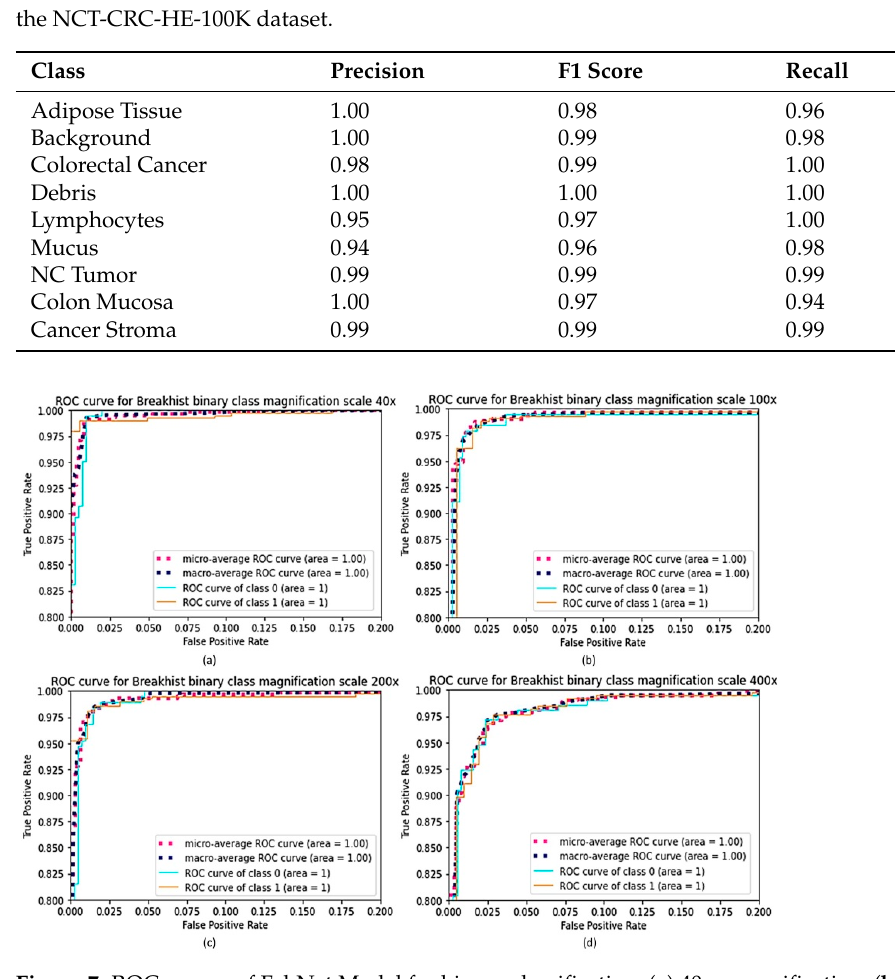
Figure 7. ROC curves of FabNet Model for binary classification, ( a ) 40× magnification, ( b ) BreakHis 100× magnification, ( c ) BreakHis 200× magnification, ( d ) BreakHis 400× magnification.